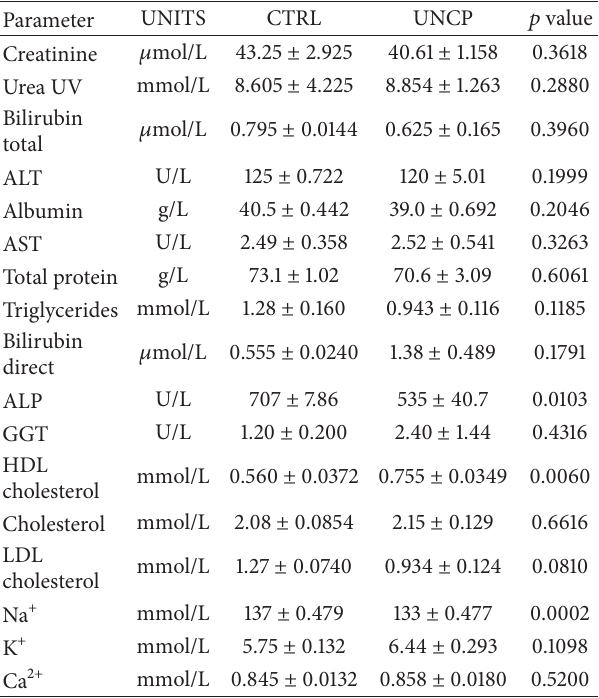
Table 5: Changes in serum biochemistry in male SD rats receiving 2000 mg/kg b.w.t. of